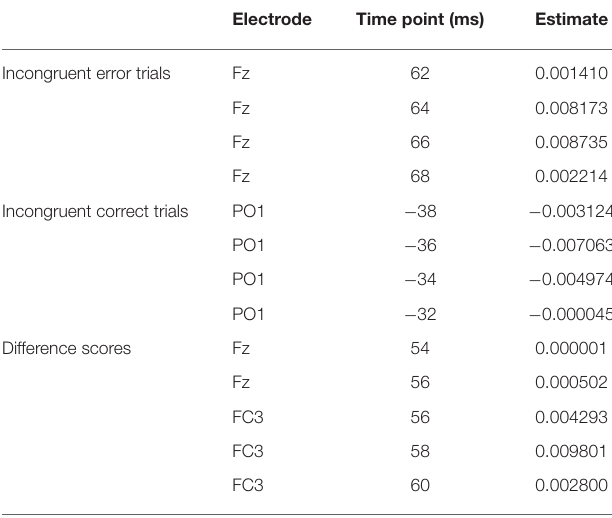
TABLE 3 | Most important variables with predictive value for SCFs defined by electrode and timepoint.